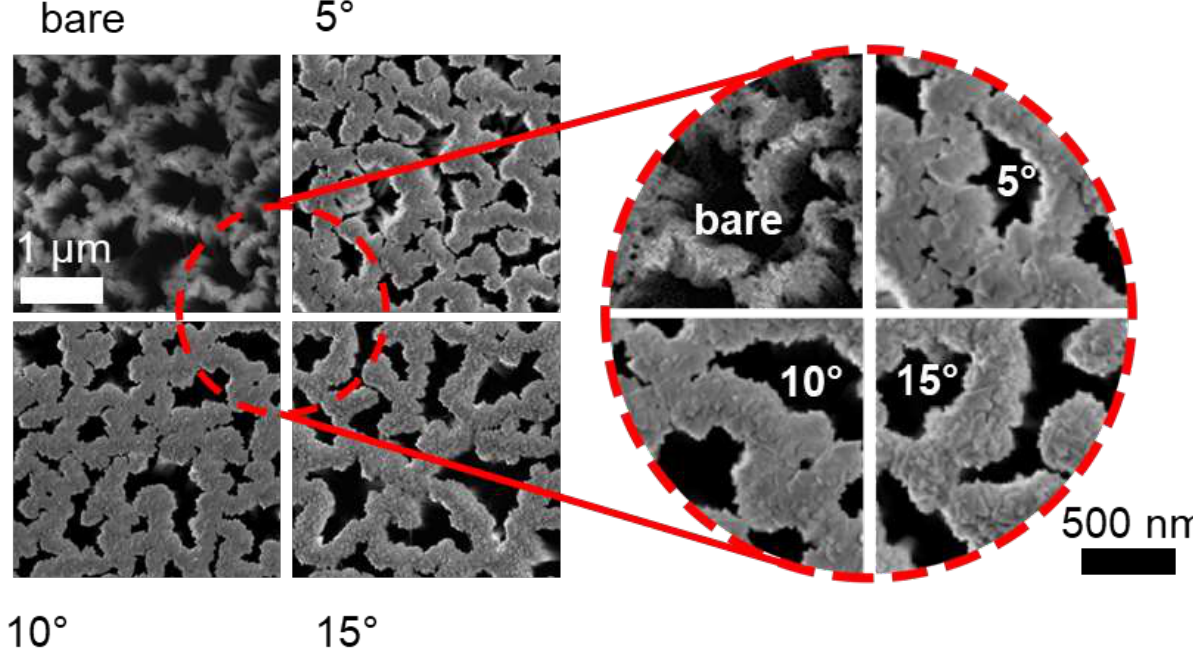
Figure 2. Plan-view SEM images of fractal bare Si NWs, 5 ◦ , 10 ◦ , and 15 ◦ Er:Y 2 O 3 decorated at the same magnification are reported on the left side. On the right side, to highlight the different coverage and filling factor, a magnification of all these images is shown.